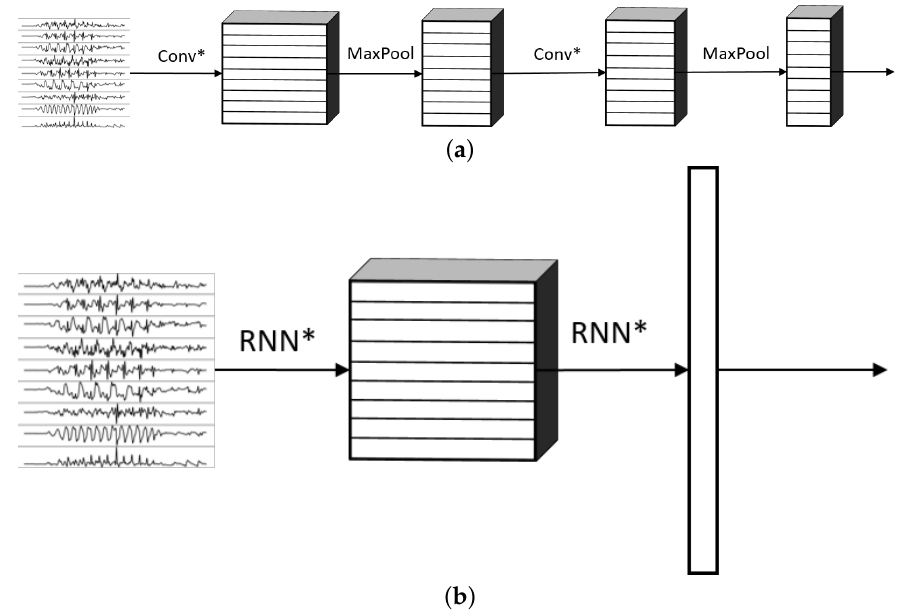
Figure 5. General CNN and RNN sub-networks for the models that combine CNNs and RNNs. The asterisks on the Conv layers mean the usage of different variations of CNNs. The asterisks on the RNN layers represent either LSTMs or bidirectional LSTMs. (FC = Fully Connected Feed Forward Neural Network.) ( a ) General CNN sub-network for the models that combine CNNs and RNNs, ( b ) general RNN sub-network for the models that combine CNNs and RNNs.